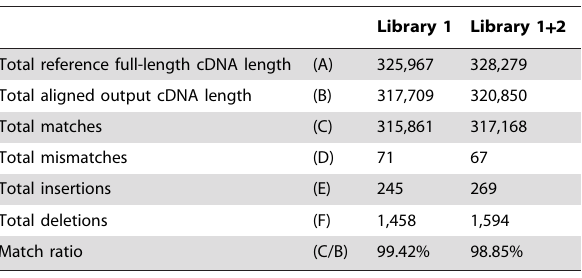
Table 3. Base accuracy of MuSICA 2 assembly.